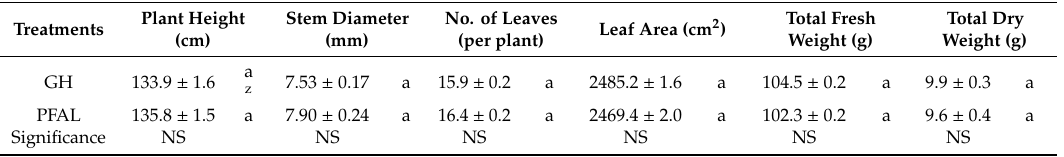
Table 8. Development of grafted cucumber seedlings after transplanting as a ff ected by the cultivation of scions and rootstocks in a PFAL and GH ( n = 7, R = 3).